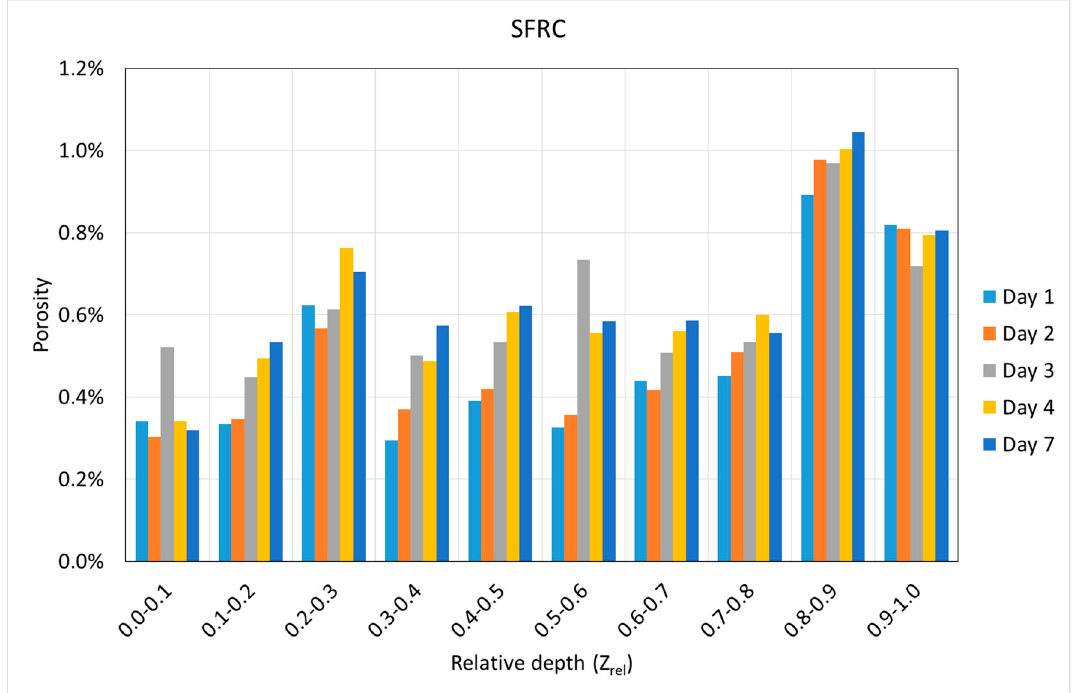
Figure 10. Variation of the porosity in steel fiber-reinforced high-performance concrete (SFRC) according to the depth and age.